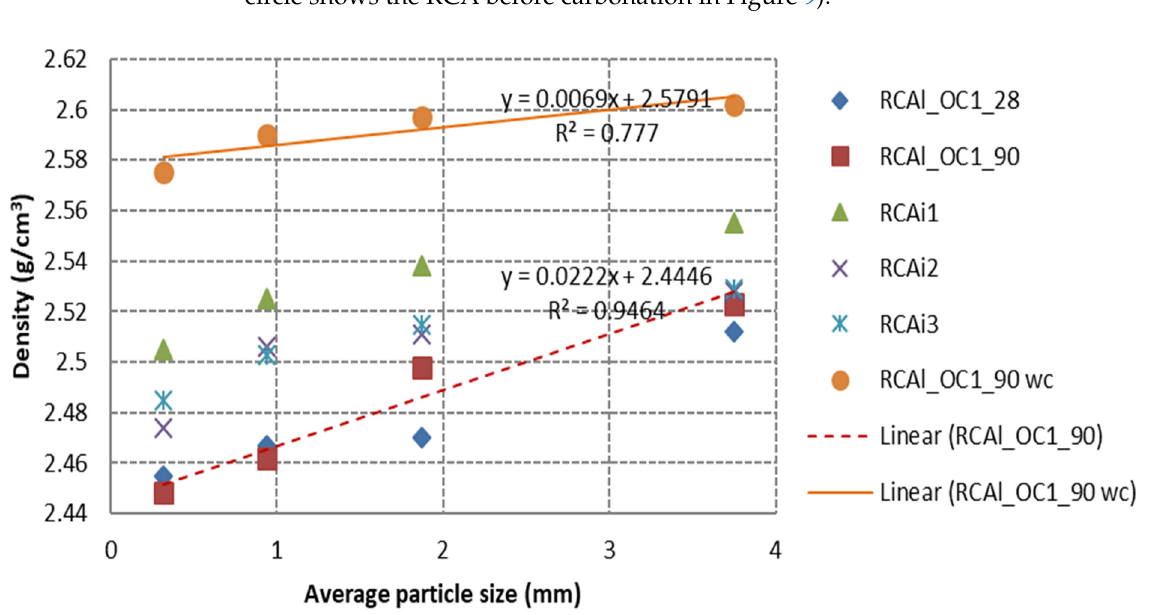
Figure 9. Density as a function of the granular classes for all studied RCA.